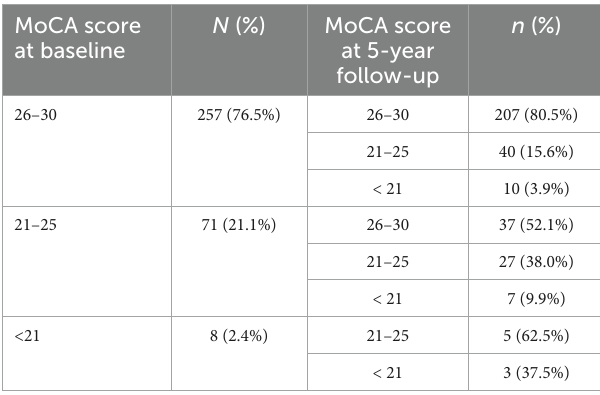
MoCA = Montreal Cognitive